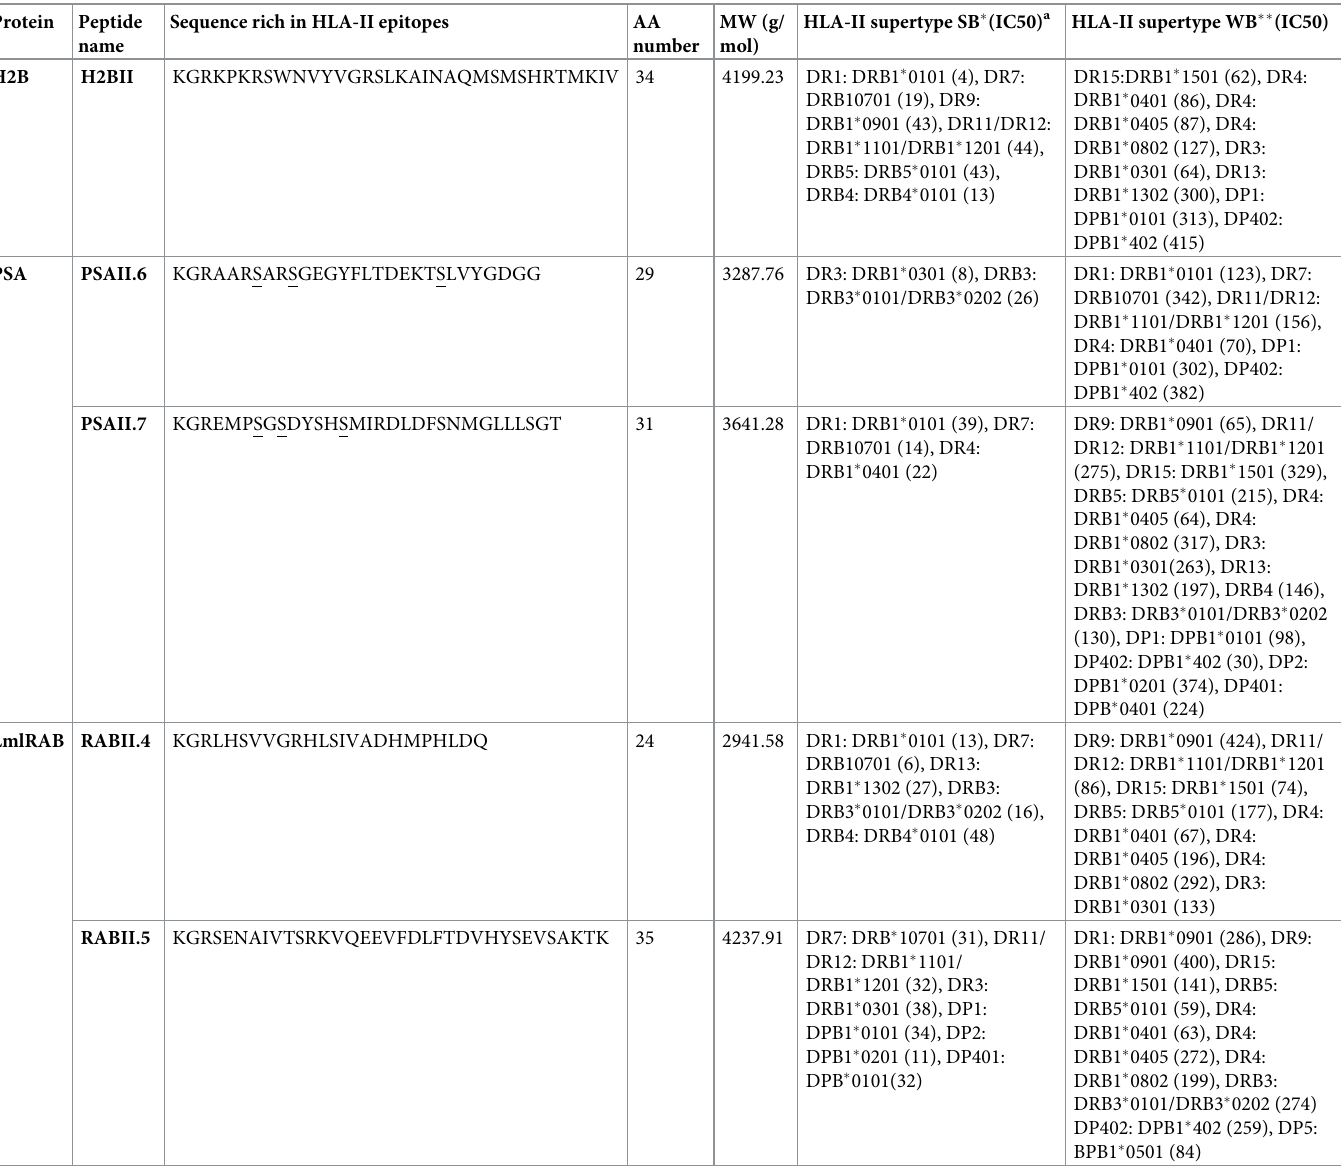
Table 6. Characteristics of in silico predicted sequence rich in HLA-II–restricted epitopes derived from H2B, PSA and LmlRAB proteins. Protein Peptide Sequence rich in HLA-II name